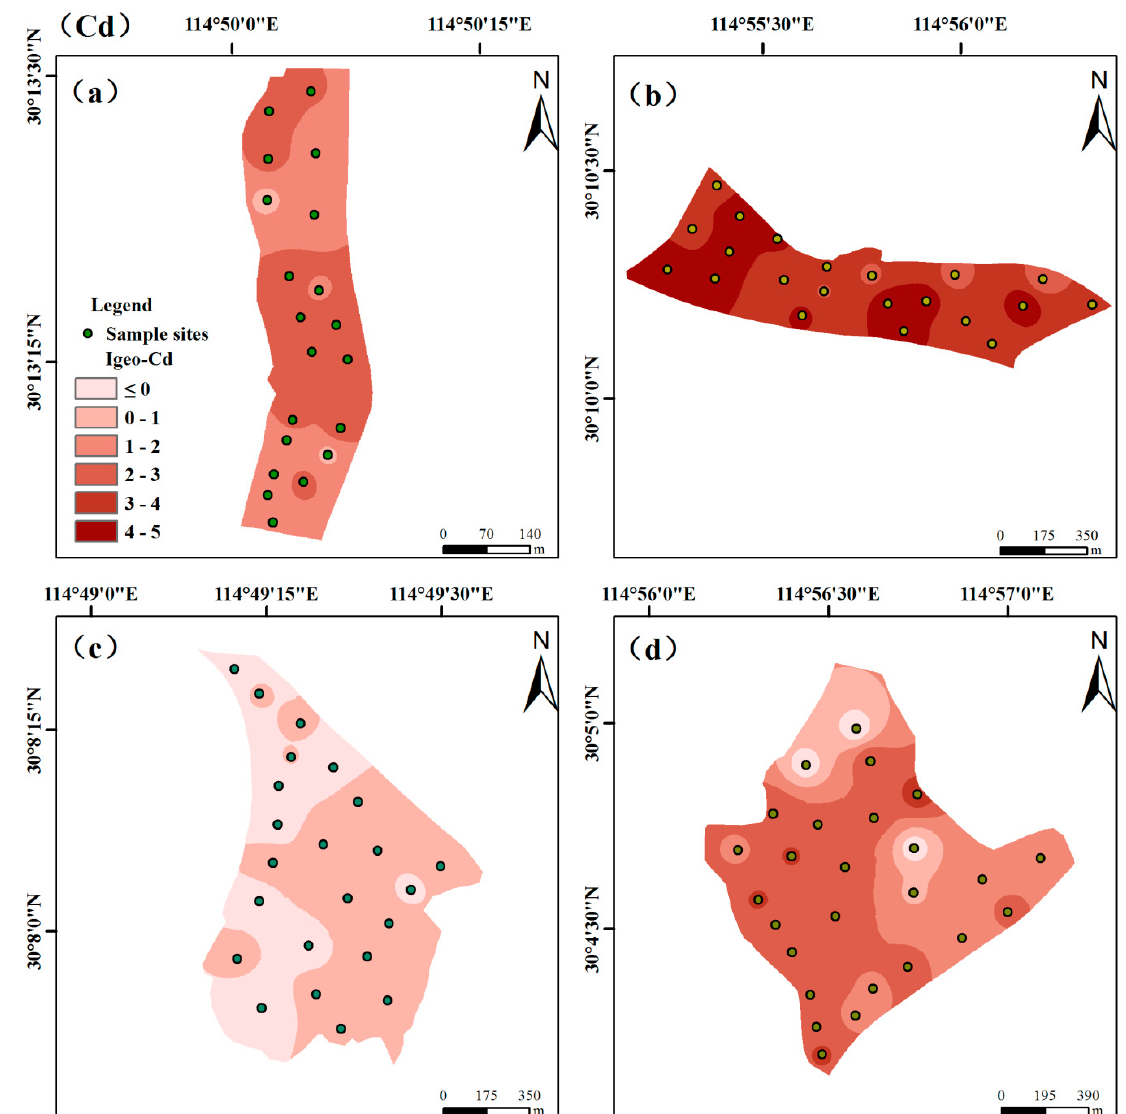
Figure 3. Spatial distribution pollution levels of Igeo-Cd in the four zones: ( a ) Non-ferrous metals smelter; ( b ) Abandoned copper mine; ( c ) Limestone quarry; ( d ) Iron mine.